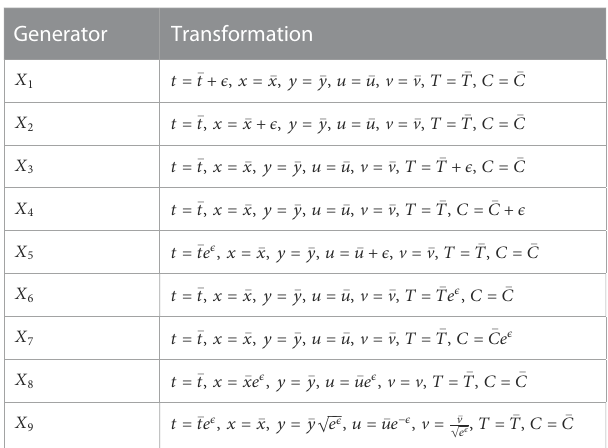
TABLE 1 Lie symmetry generators and